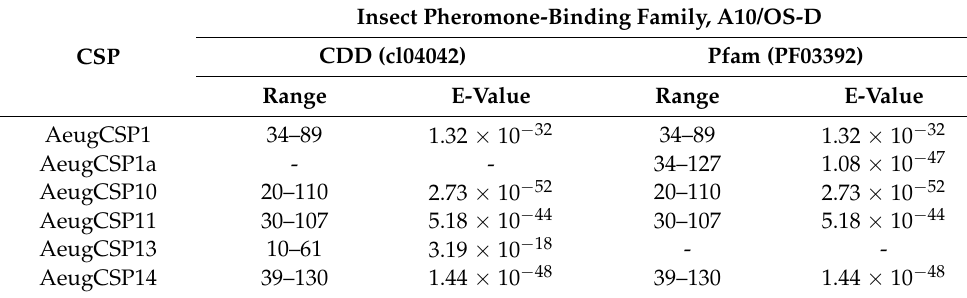
Table 2. Functional annotation of AeugCSPs, based on CDD/SPARCLE database.